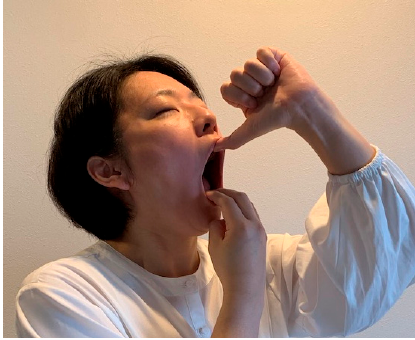
Figure 1. Jaw-opening exercise with pain (JE w/pain group): using their own hands, the participants performed the jaw-opening exercise passively to the point of pain in the TMJs and/or masticatory muscles (masseter and/or temporalis). The opened position was maintained for 10 s.